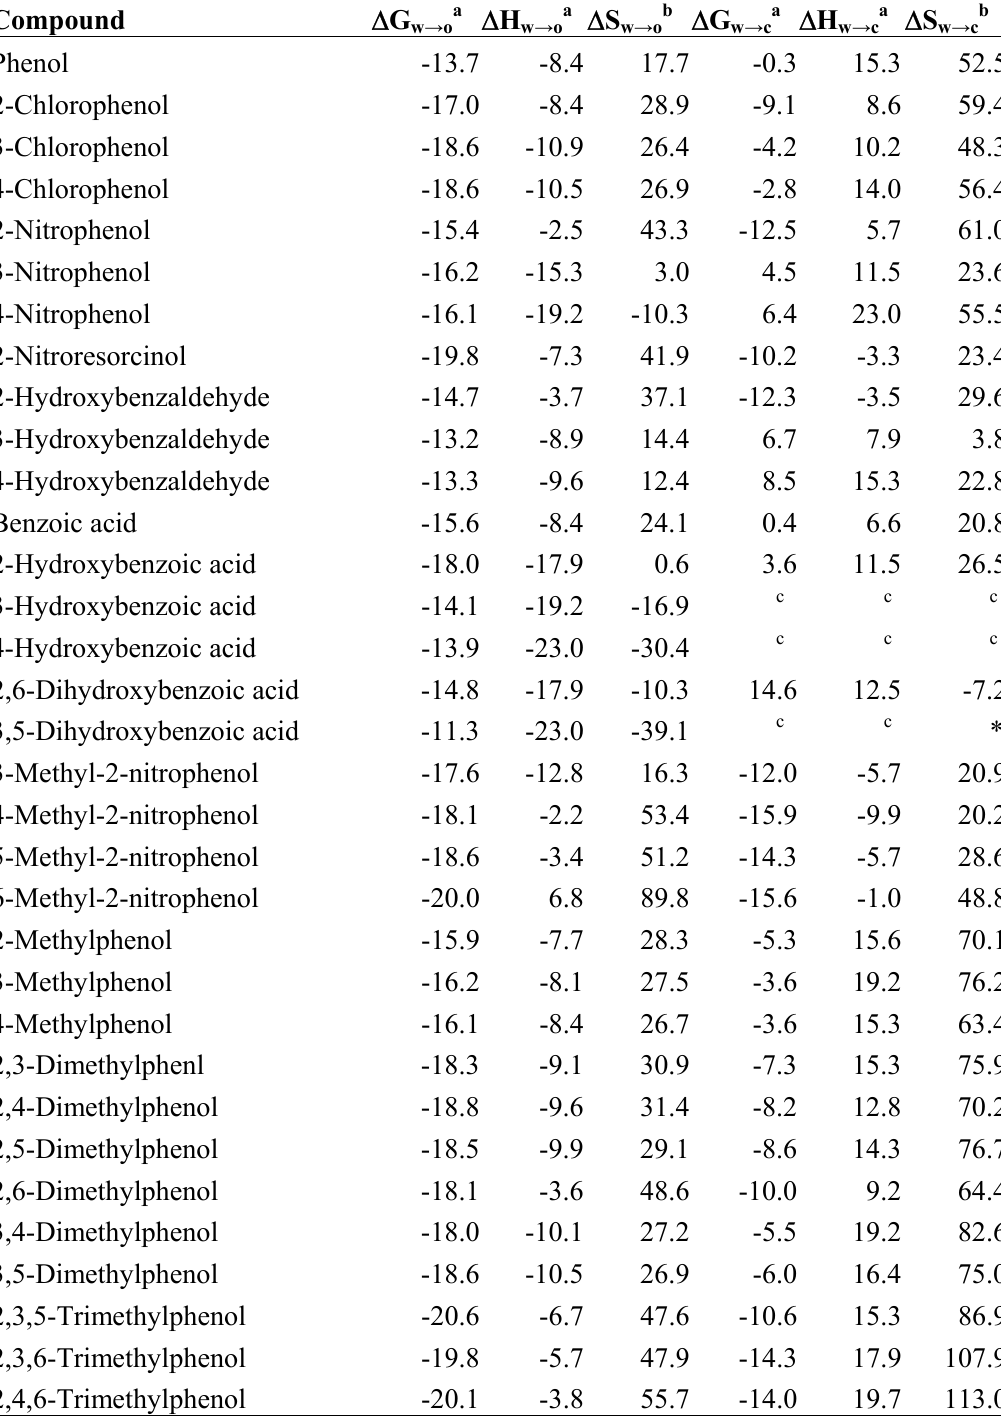
Table 1. Thermodynamic parameters (mole fraction scale) of partitioning from water to octanol (w → o) and from water to cyclohexane (w → c)